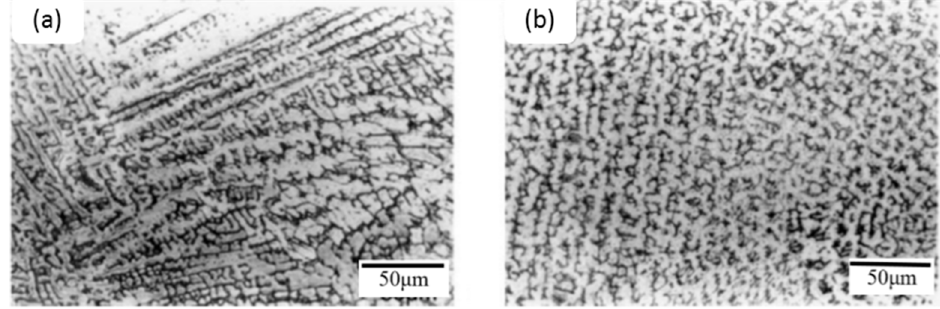
Figure 7. Optical microstructure of 316L TIG welded zone with 0.03% Ce. ( a ) Near fusion boundary and ( b ) weld center (400×) [50].